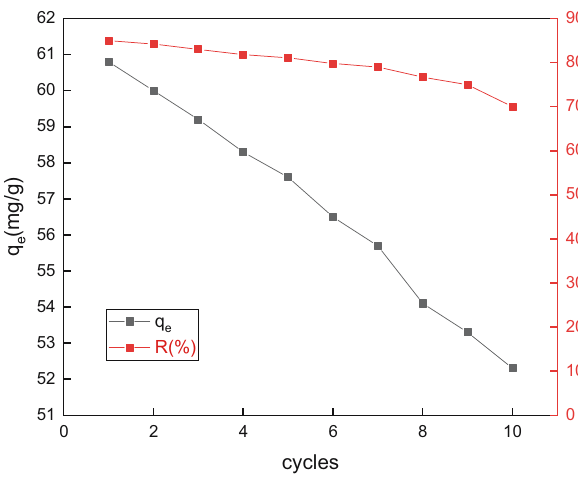
Figure 10: Changes in adsorption capacity and adsorption rate of Cu 2 + by adsorption and desorption of GC for ten